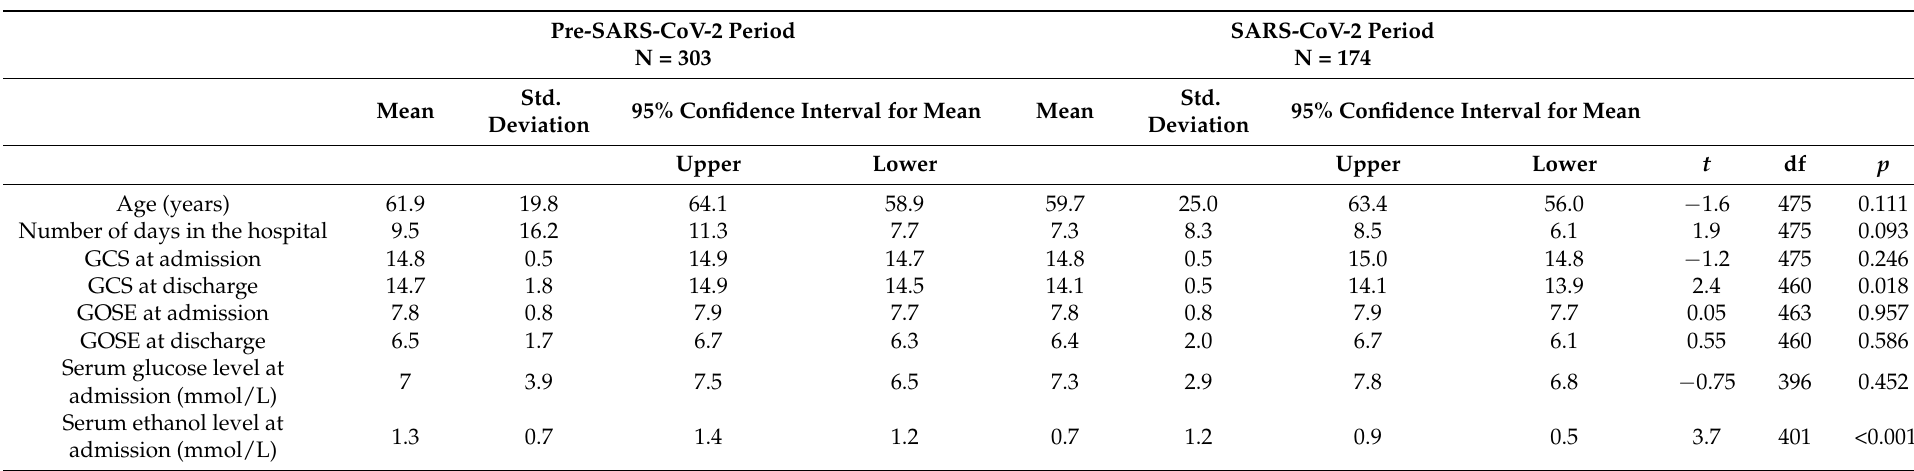
SARS-CoV-2 Period N = 174 Std. 95% Confidence Interval for Mean Deviation